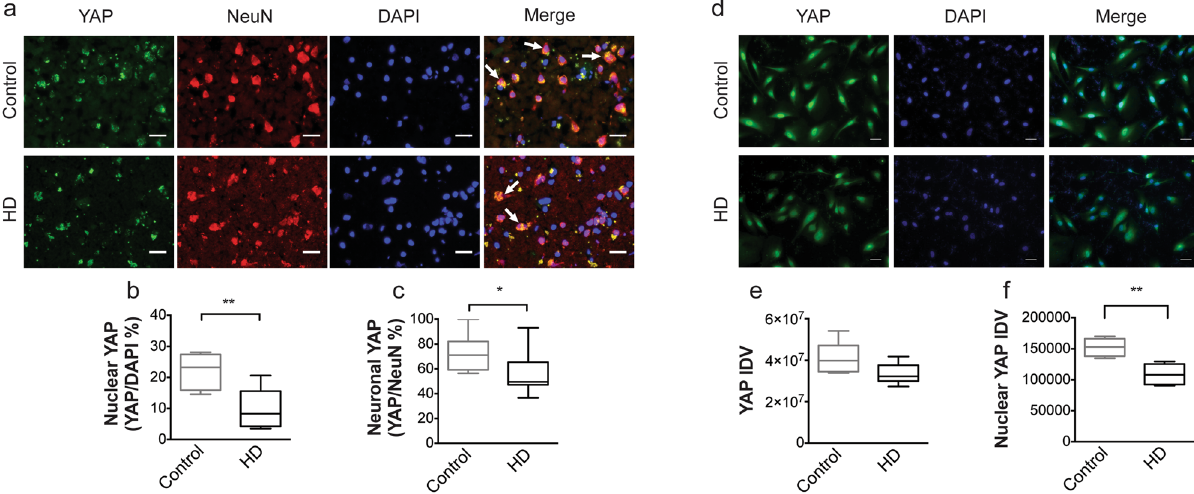
Figure 1. YAP subcellular localization in human post-mortem cortex and NSCs derived from HD patients. ( a ) Representative images from unaffected control (top; n = 7) and HD (bottom; n = 10) human cortical tissue stained with YAP (green), NeuN (red), and DAPI (blue) (left to right). Merged images (far right) show overlap of YAP, NeuN and DAPI. Arrows highlight representative cells; scale bar = 50 μ M. ( b ) The percentage of NeuN + cells that were YAP + (YAP/NeuN%) was significantly lower (p = 0.0250, Mann-Whitney U Test) in HD (black) compared to control (grey) human tissue. ( c ) The percentage of DAPI + cells that were YAP + (YAP/DAPI%) was significantly lower (p = 0.0020, Mann-Whitney U Test) in HD compared to control tissue. ( d ) Representative images from unaffected control (WAD9) (top; n = 5) and HD (G018) (bottom; n = 6) human embryonic-derived NSCs stained with YAP (green; left) and DAPI (blue; middle). Merged images (right) show overlap of YAP and DAPI. Scale bar = 25 μ M. ( e ) Overall YAP intensity was not different (p = 0.1255, Mann- Whitney U Test) between control (grey) and HD (black) NSCs. ( f ) Nuclear YAP staining was significantly lower (p = 0.0043, Mann-Whitney U Test) in HD compared to control tissue. Data are presented as median and min- max values. * p < 0.05, ** p < 0.01.